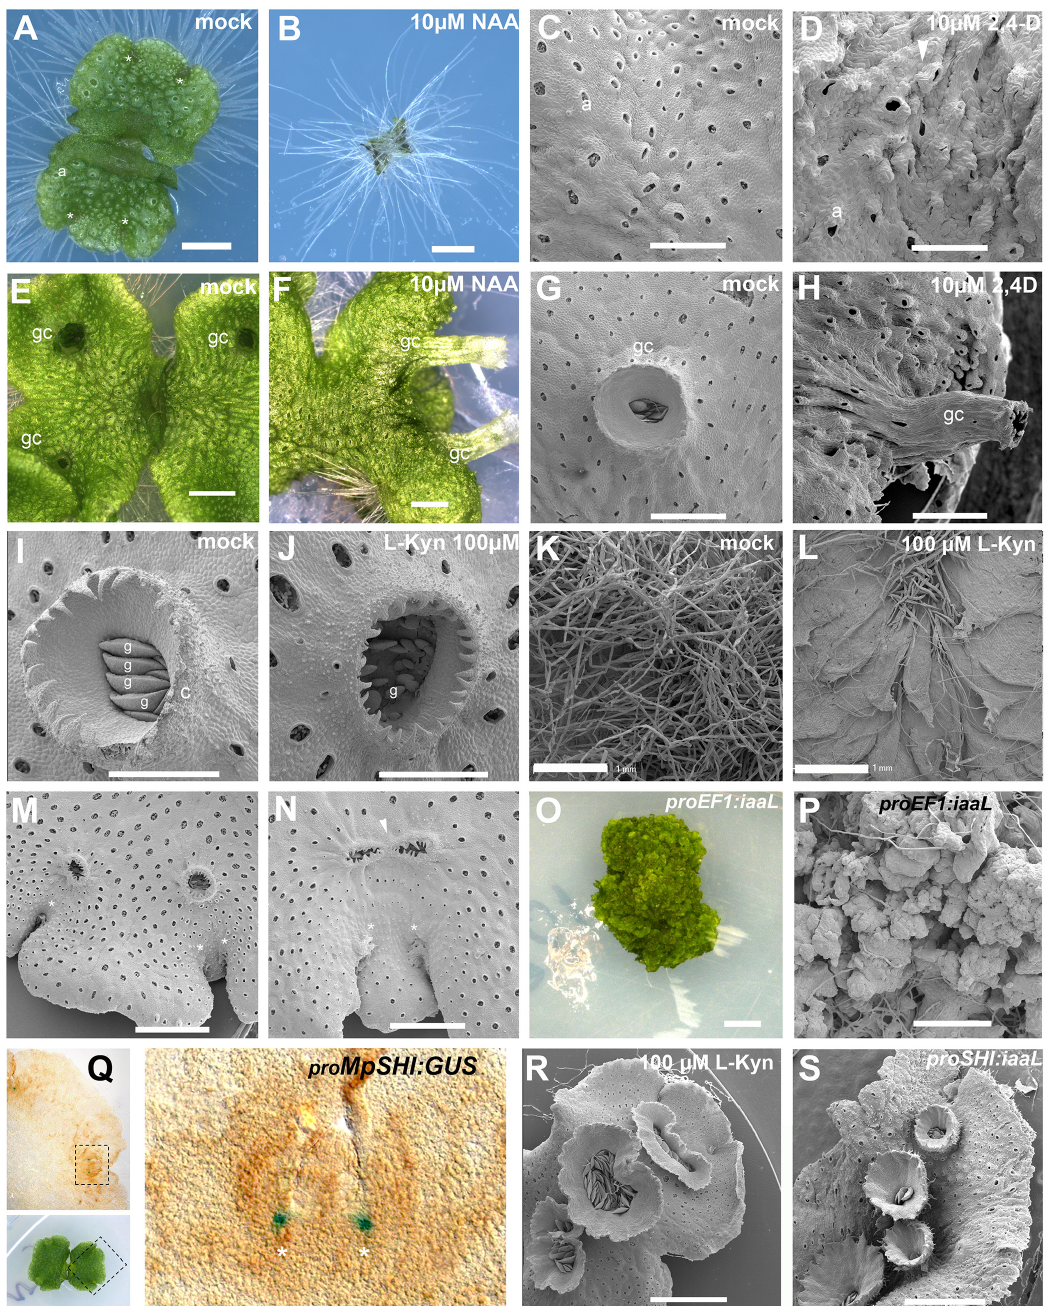
Fig 1. Developmental effects of auxin in the M . polymorpha thallus. (A) 10-day-old wild-type gemmaling with four apical notches and well developed air pores. (B) 10-day-old wild-type gemmae grown on 10 μ M NAA. (C) Dorsal epidermis of 15-day-old wild-type thallus. (D) Dorsal epidermis of 15-day-old wild- type thallus, transferred on day 6 to 10 μ M 2,4-D with abnormal air pores. (E) 18-day-old wild-type thallus with three gemmae cups. (F) 23-day-old wild-type thallus transferred at day 16 to 10 μ M NAA with elongated gemmae cup. (G) Wild-type mature gemmae cup. (H) Wild-type mature gemmae cup from 17-day- old plant, transferred at day 12 to 10 μ M 2,4-D. (I) Wild-type mature gemmae cup with gemmae inside. (J) Wild-type mature gemmae cup from a plant grown on 100 μ M L-Kyn. (K) Ventral side of wild-type thallus grown on mock media. (L) Ventral side of wild-type thallus grown on 100 μ M L-Kyn; a decrease in rhizoid number exposes ventral scales. (M) Mature thallus showing a thallus lobe separating two recently bifurcated apical notches. (N) Mature thallus of plants transferred on day 7 to 100 μ M L-Kyn, showing a smaller lobe spacing apical notches and fused gemmae cup primordia (arrowhead). (O) Strong pro EF1 : iaaL lines are composed of an undifferentiated mass of cells that fail to establish a clear dorsiventrality. (P) Close up view of pro EF1 : iaaL line shows a mass of undifferentiated cells although rhizoids are able to differentiate. (Q) Expression pattern of pro MpSHI in mature thallus with staining in the vicinity of the apical cell. (R) Different degrees of gemmae cup fusion observed in 100 μ M L-Kyn treated plants. (S) pro MpSHI : iaaL plants show an irregular zig-zag